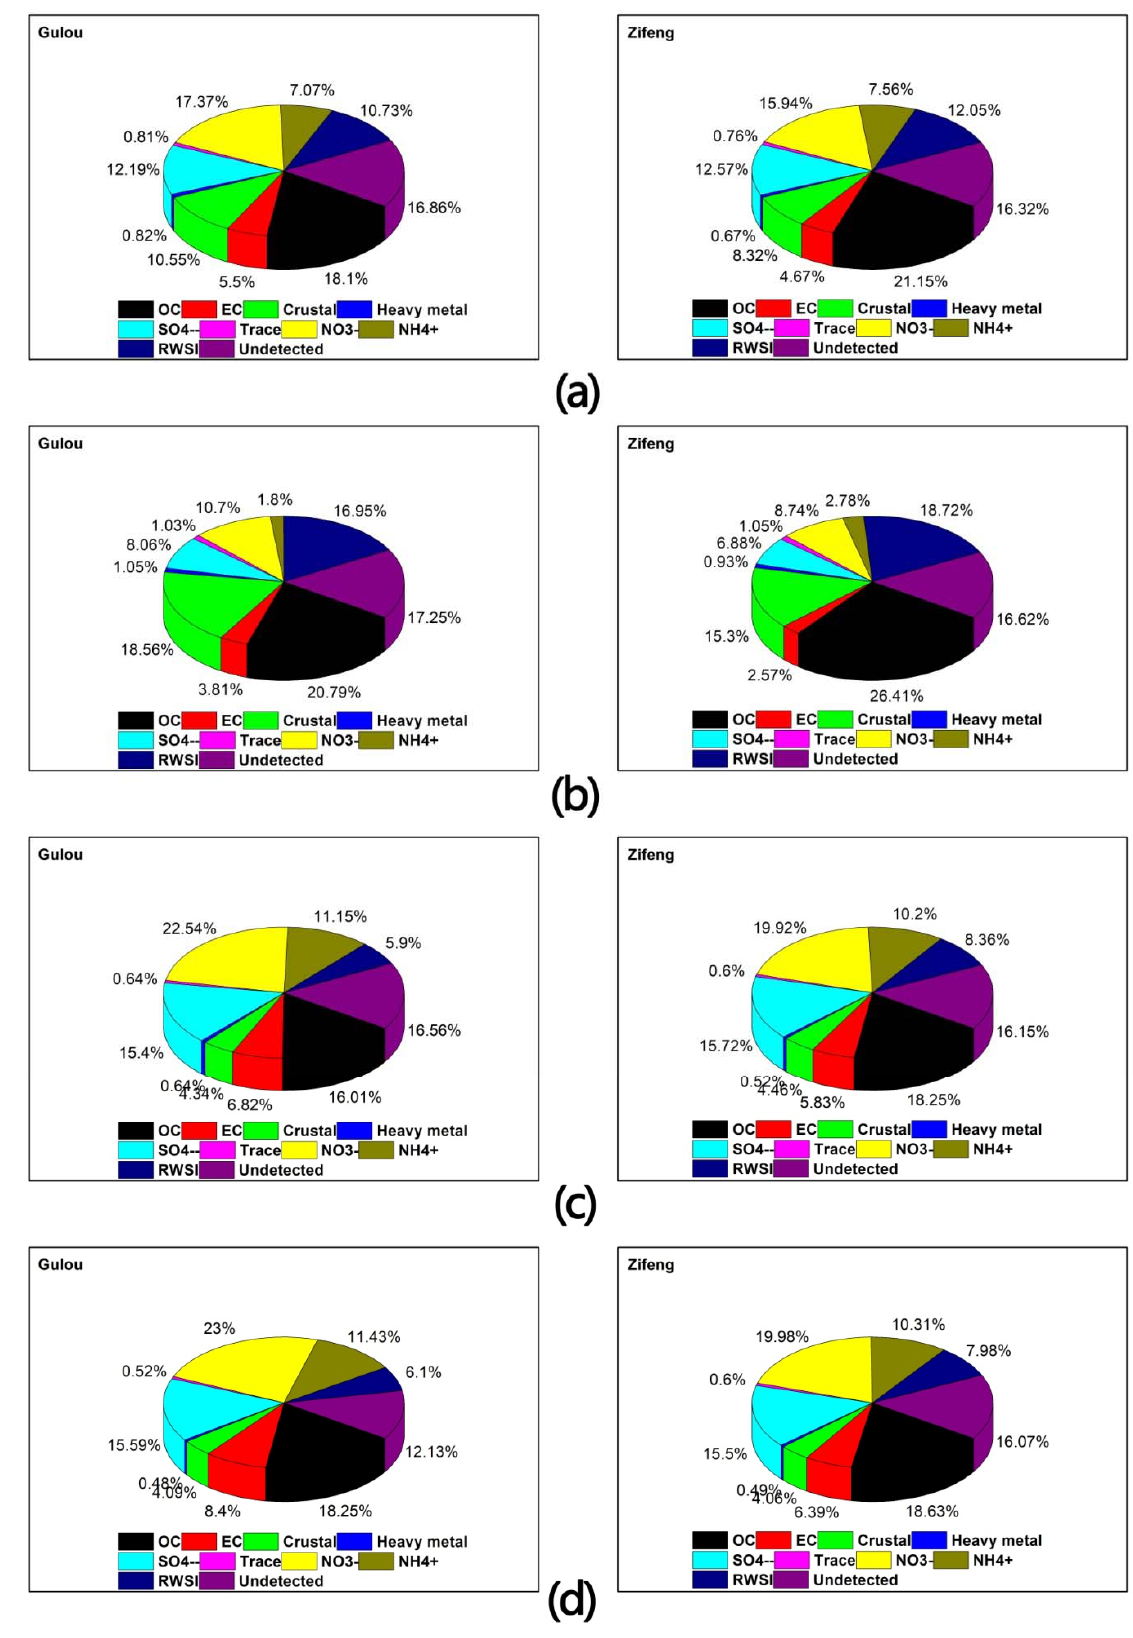
Figure 5. The percentages of chemical compositions in ( a ) PM 10 , ( b ) PM 10-2.1 , ( c ) PM 2.1 , and ( d ) PM 1.1 at Gulou and Zifeng.